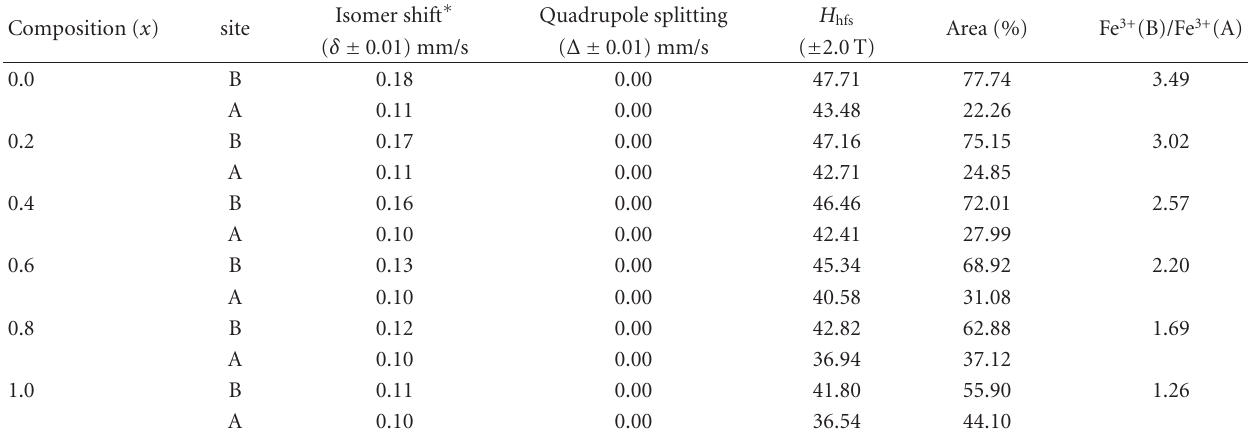
Table 4: Room temperature M¨ossbauer’s e ff ect parameters for MnAl x Fe 2 . 0 − x O 4 system as a function of x . Composition ( x